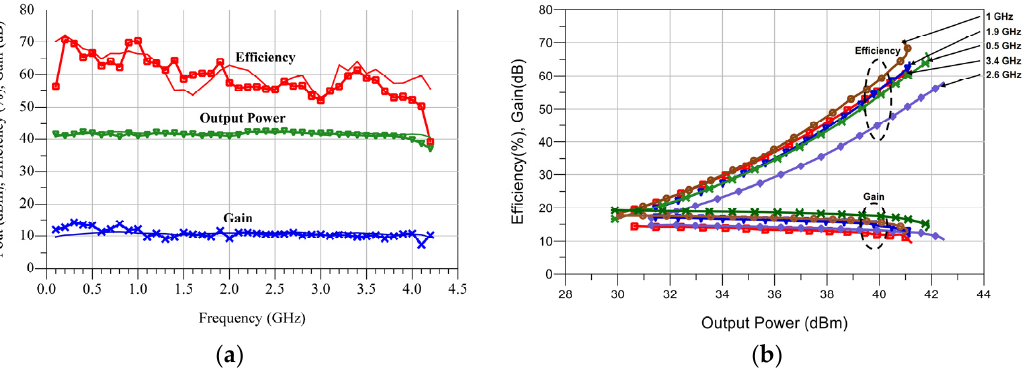
Figure 6. ( a ) CW characterization versus frequency. Solid lines: simulation results. Symbols: measurements. ( b ) Measured output power and efficiency profiles.